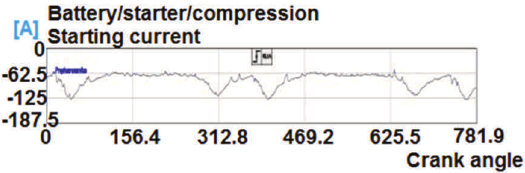
Fig. 12. Starting current for two spark plugs